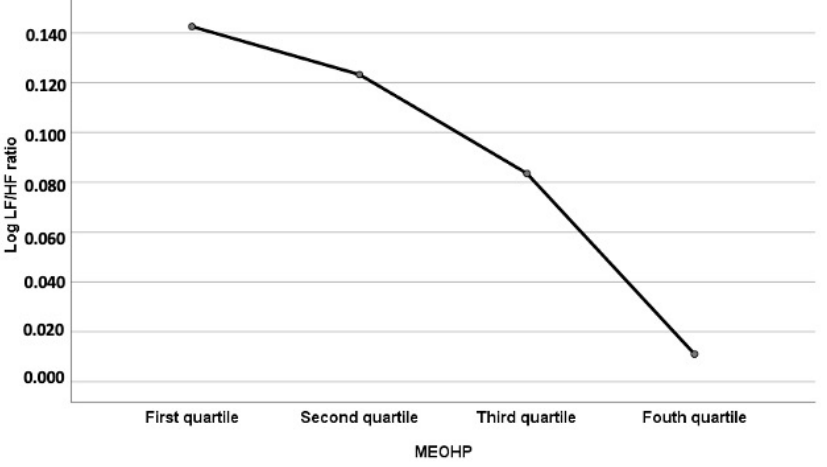
Figure 2. Means plot of log LF/HF ratio among four exposure groups categorized by the four quartiles of MEOHP measurements. Abbreviations: MEOHP: mono-(2-ethyl-5-oxohexyl) phthalate, LF: low frequency, HF: high frequency.